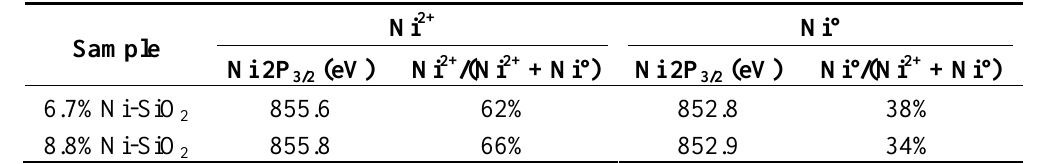
and the percentage of Ni 2+ and Ni° for the 3/2